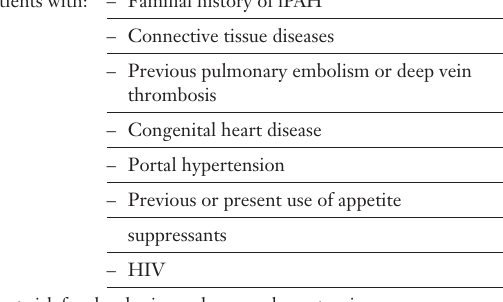
Screening of patients at risk for pulmonary